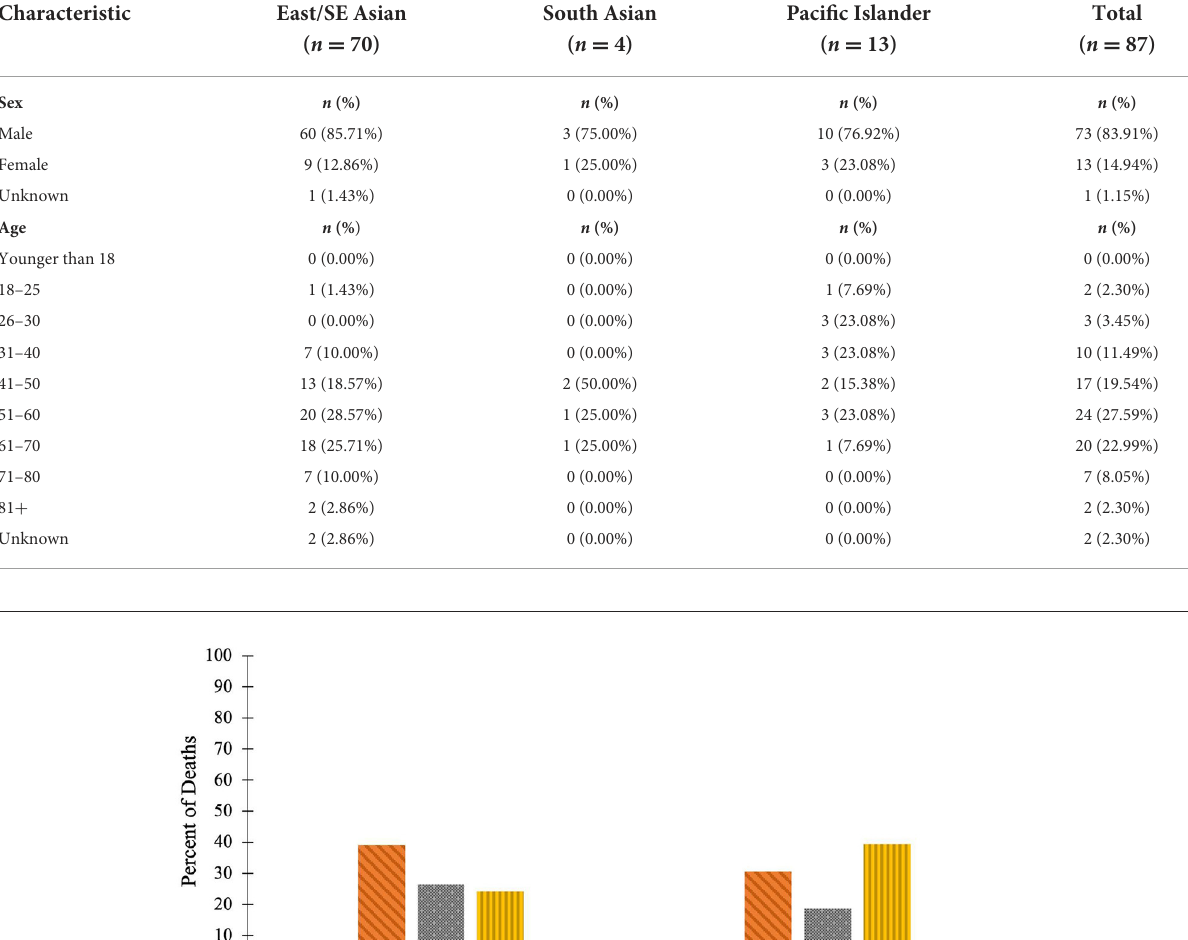
TABLE 2 Characteristics of the API sub-groups ( n = 87).